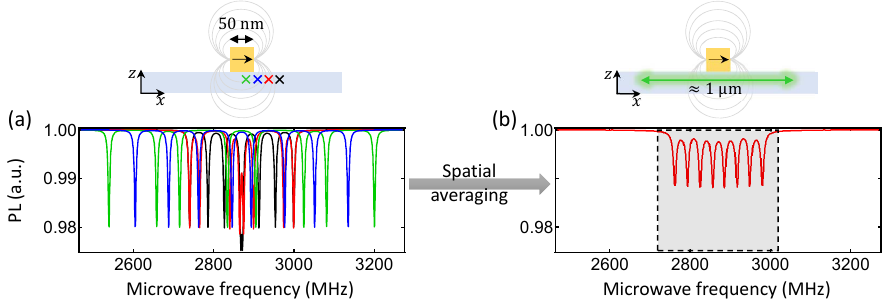
Figure 3. Simulated ODMR spectra for NV centres at a stand-off d = 20 nm from a 50 × 50 × 50 nm 3 particle magnetised along x with M s = 10 6 A/m, assuming for simplicity a field-independent ODMR contrast of 2% (that is, spin-state mixing caused by large magnetic fields [34] is neglected). ( a ) shows ODMR spectra for point-like ensembles of NV centres at different locations relative to the particle (arbitrarily chosen for illustration purpose), whereas ( b ) shows a spatially averaged ODMR spectrum given a 1 µ m optical resolution. The grey-shaded box in ( b ) indicates the experimentally scanned frequency